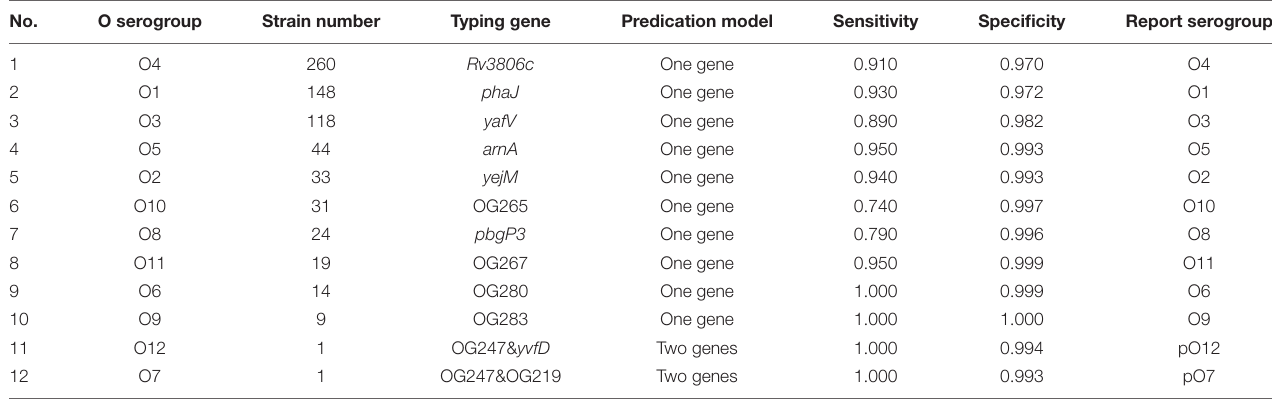
TABLE 1 | O serogroup typing genes by VPsero and corresponding sensitivity and specificity. Strain number Typing gene Predication model Sensitivity Specificity Report